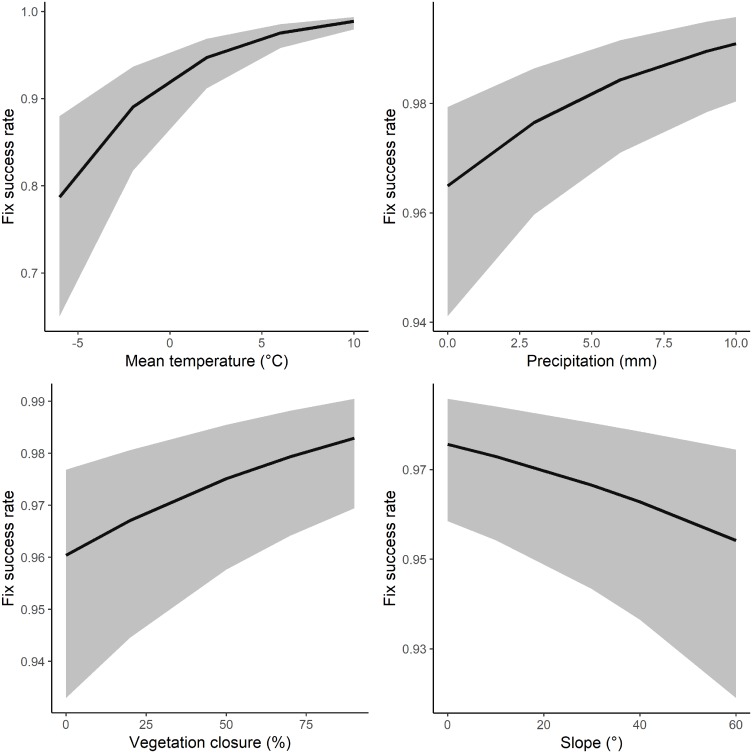
The effect of mean temperature (top left), precipitation (top right), canopy closure (bottom left) and slope (bottom right) on the fix success rate of GPS receivers during stationary tests.